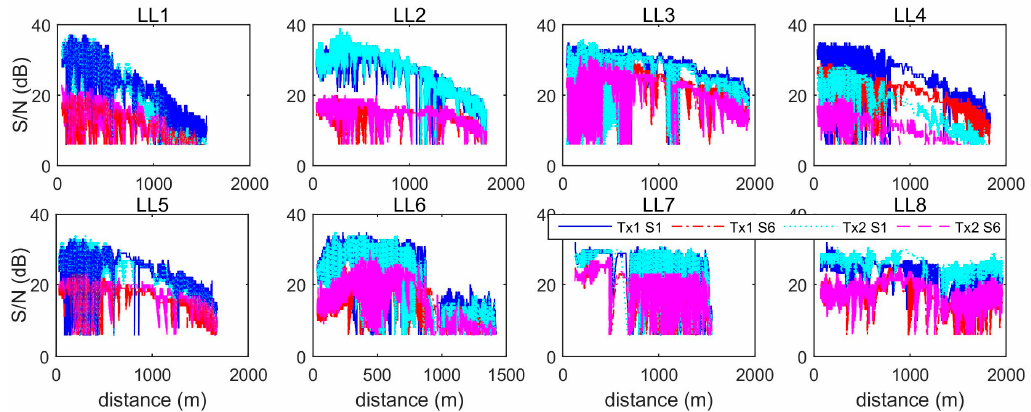
Figure 9. Trends of signal-to-noise ratio (dB) with respect to distance.